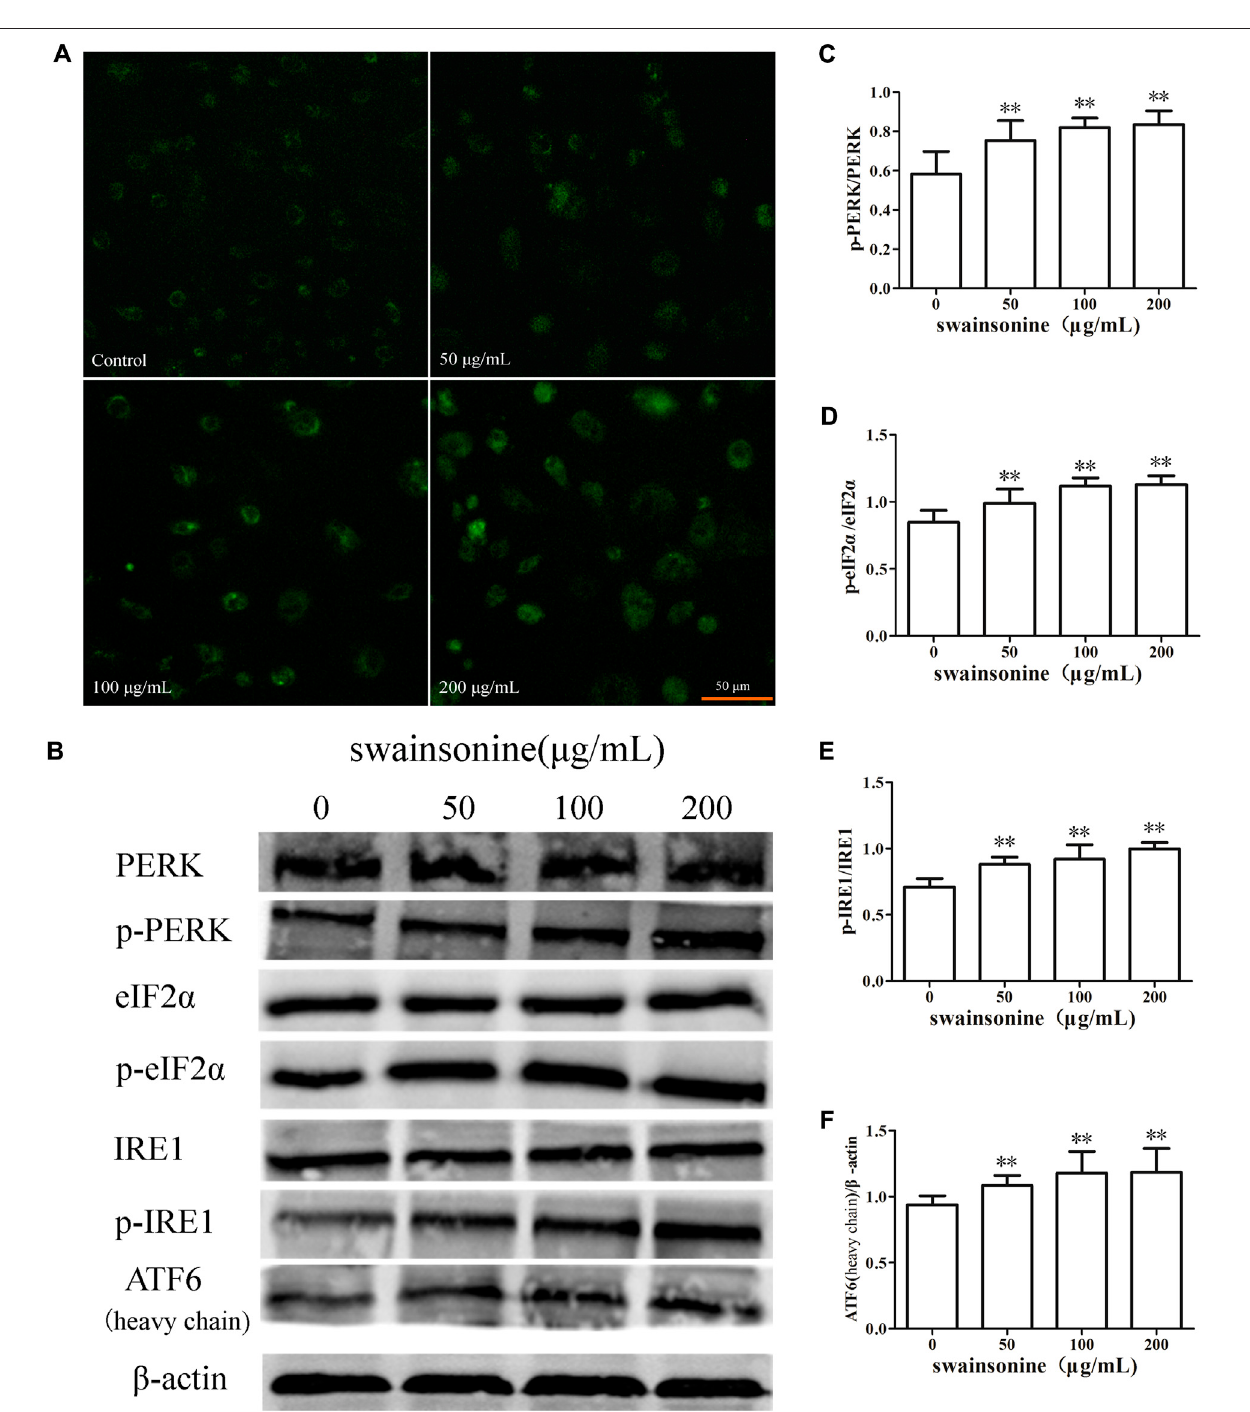
FIGURE 7 | SW increases Ca 2+ concentration and activates pathways related to ER stress in RTECs. RTECs treated with various doses of SW for 24 h (A) SW treatmentcausedanincreaseinCa 2+ concentrationsinRTECscomparedwithuntreatedcells (B) PERK,eIF2 α ,IRE1,ATF6expressionlevelswereevaluatedbyWestern blot analysis (C – F) These column charts show the ratio of p-PERK/PERK, p-eIF2 α /eIF2 α , p-IRE1/IRE1, ATF6/ β -actin. Three independent experiments were performed. Statistically signi fi cance was indicated: * p < 0.05, ** p < 0.01 compared with control.